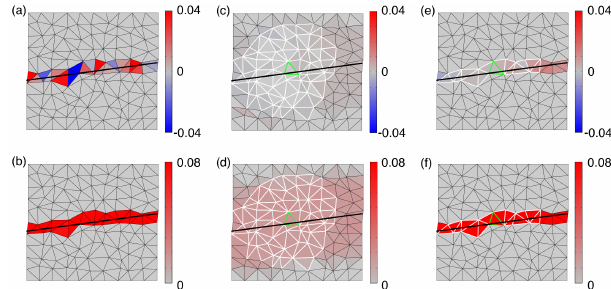
Figure 1. Example of the divergence (a, c, e) and shear (b, d, f) obtained for the single-crack test case at a normalized resolution of 0.1. The relative displacement parallel and normal to the crack (black line) are set to 0.01 and 0, respectively. (a) and (b) corre- spond to the unfiltered deformation fields, (c) and (d) to the de- formation fields filtered with a classical smoothing kernel and (e) and (f) to the deformation fields filtered with our smoother. Tri- angles in white show the kernel defined for the triangle in green. With both smoothers the kernel corresponds to cells that can be reached by crossing a maximum of n edges (here n = 7). The classi- cal smoother takes all the cells into account, whereas our smoother only takes into account the cells whose deformation is above a given